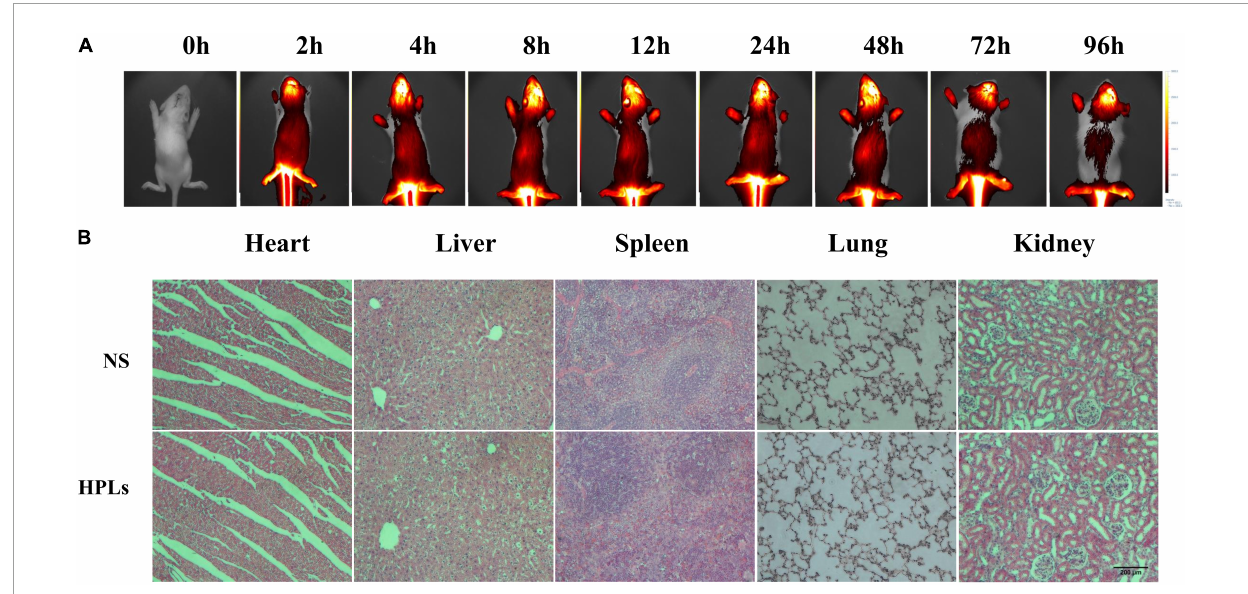
FIGURE4 HPLs have good targeting and biosafety in TBI models. (A) Fluorescence distribution in rats of different time point after injection of DiR-LIP (B) Histological examination of the heart, liver, spleen, lung, and kidney samples excised from CCI rats on the 7th day after the respective treatment with saline and HPLs. The images were observed under a microscope at a magnification of 400 times.